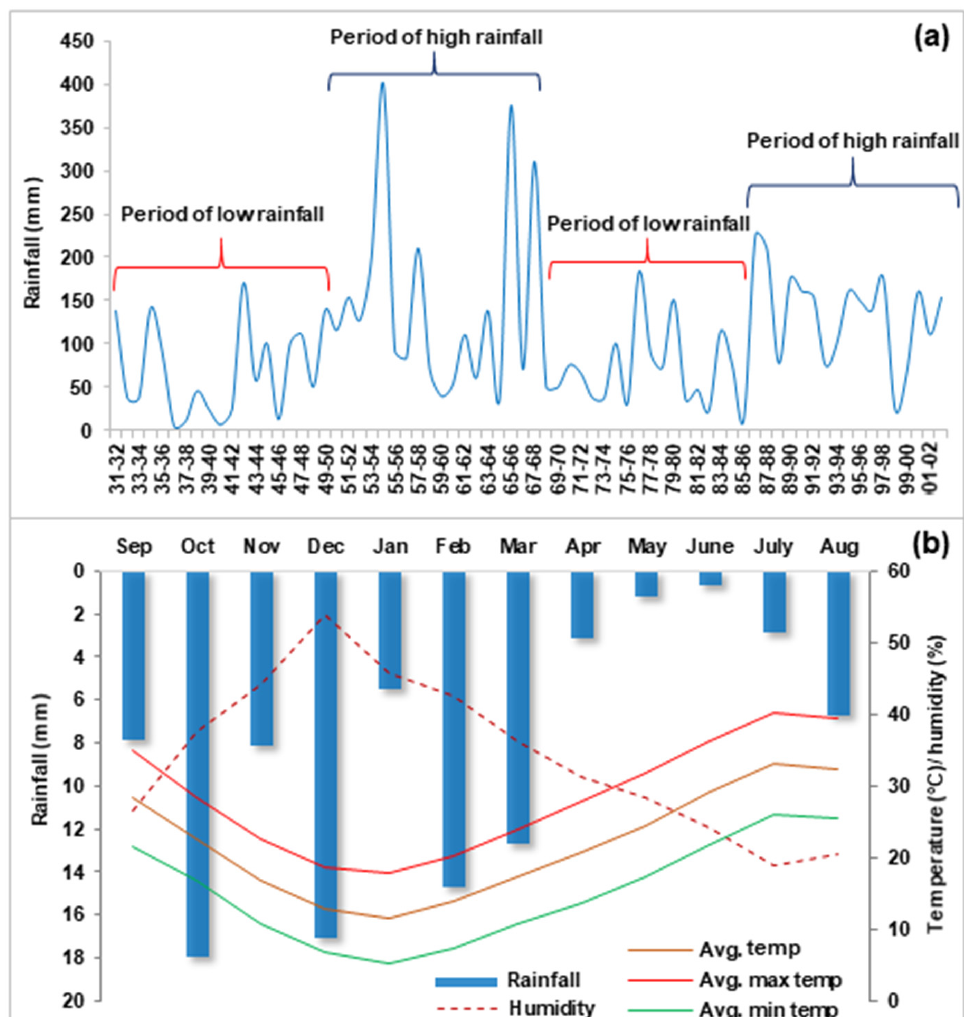
Figure 2. ( a ) Average annual rainfall registered at the Tata station (1931–2001) and ( b ) average monthly rainfall, temperature, and humidity at the Tata station (1985–2020).